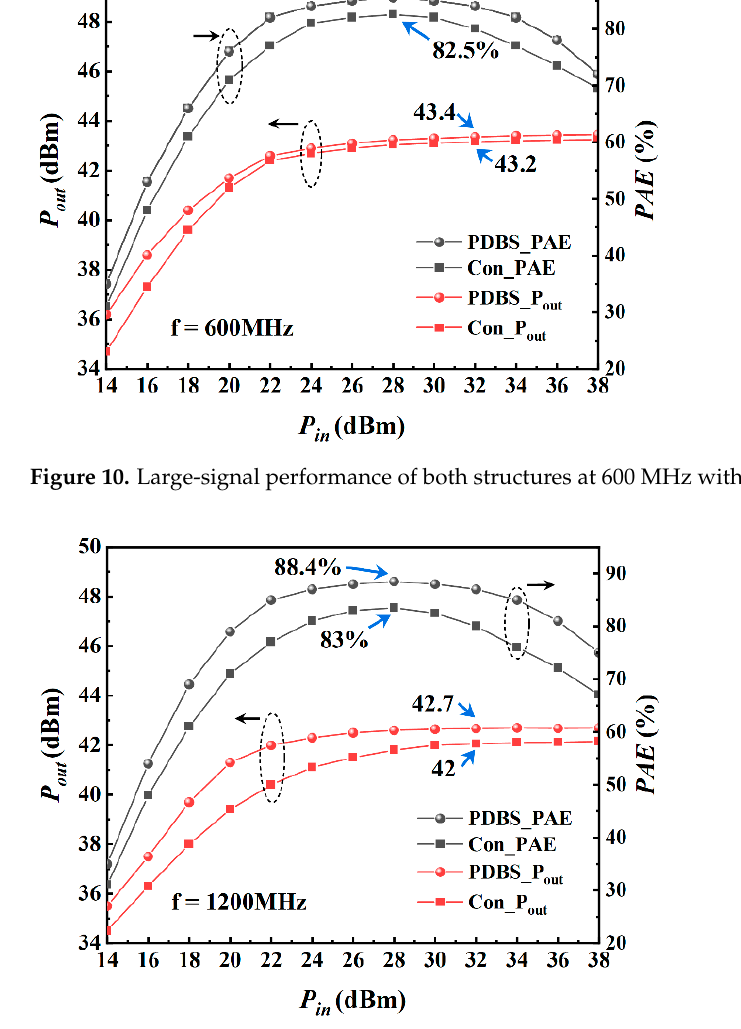
Figure 11. Large-signal performance of both structures at 1200 MHz with V gs = − 4 V, V ds = 20